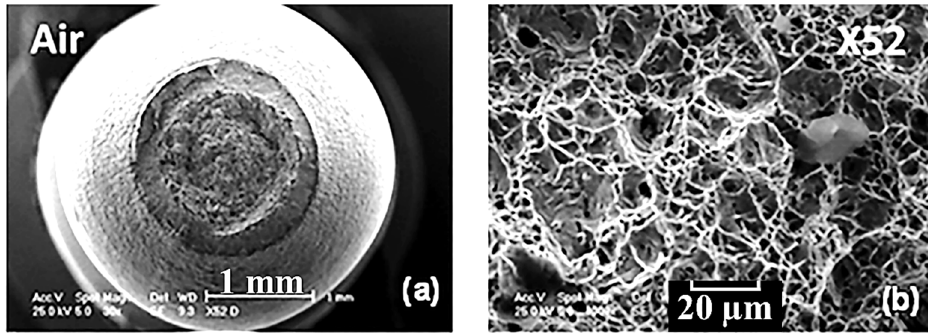
Figure 12. SEM images showing a ductile type of fracture on the X52 exposed specimens in air [67].